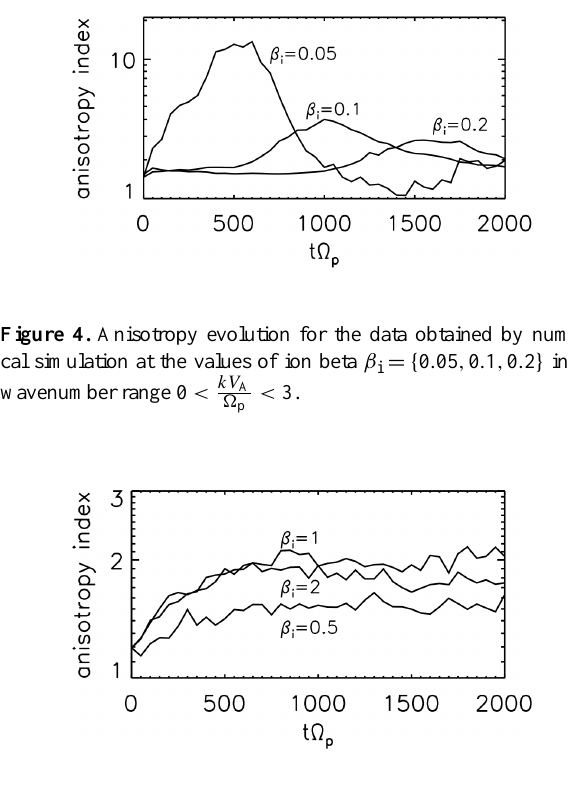
Figure 5. Anisotropy evolution for the data obtained by numerical simulation at the values of ion beta β i = { 0 . 5 , 1 , 2 } in the wavenum- < ber range 0 < kV A (cid:127) p